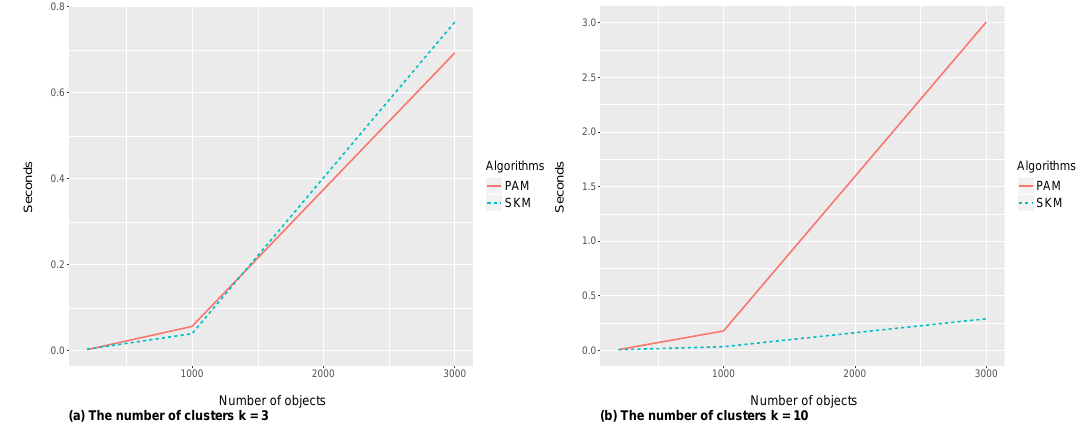
Figure 3. Benchmarking of PAM and SKM for k = 3 ( a ) and k = 10 ( b ) with set . seed ( 2018 ) .